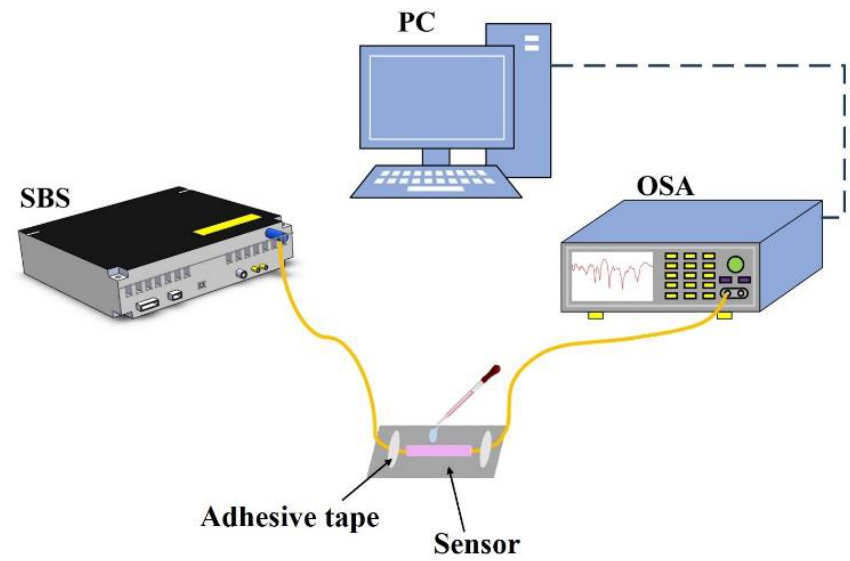
Figure 5. The experimental setup for refractive index measurement.